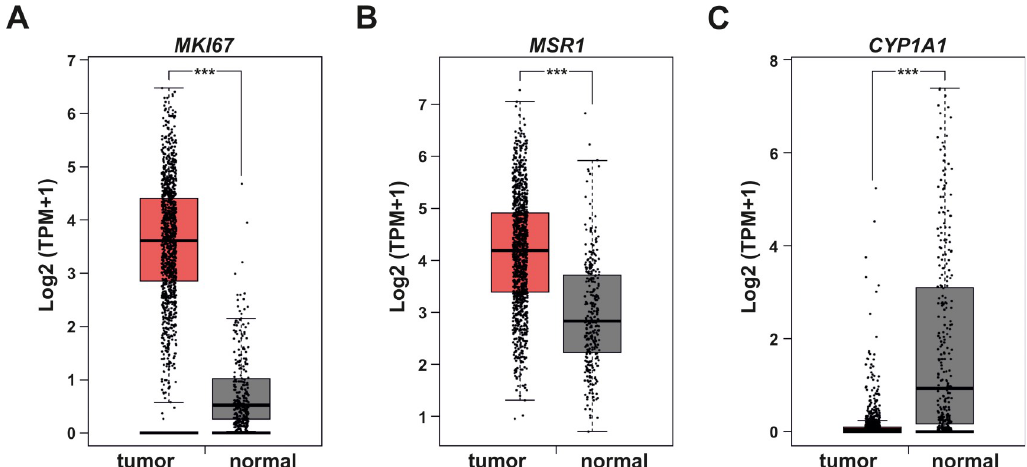
Fig 6. Clinical breast cancer data. For the evaluation of patient data publicly available breast cancer RNA seq data sets were analyzed using the interactive web server GEPIA. Expression of the proliferation marker MKI67 (A), the M F marker MSR1 (B), and CYP1A1 (C) was compared between normal and tumor samples and is given as log2(TPM+1) ( ��� p < 0.001).